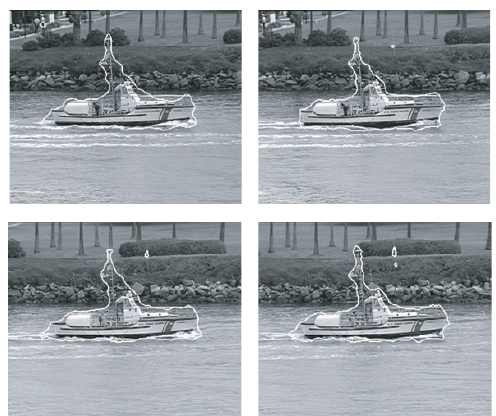
Figure 5: Coastguard: final contours in